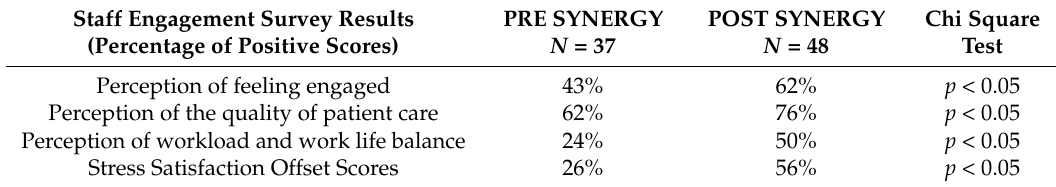
Table 3. HHSC Hematology Nurse Survey Ratings of Engagement.